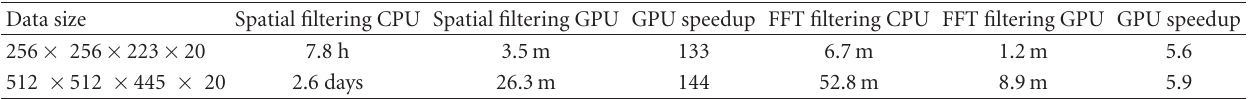
Table 6: Total processing times for the complete 4D image denoising algorithm for the di ff erent implementations. The processing times for the GPU DO include the time it takes to transfer the data to and from the